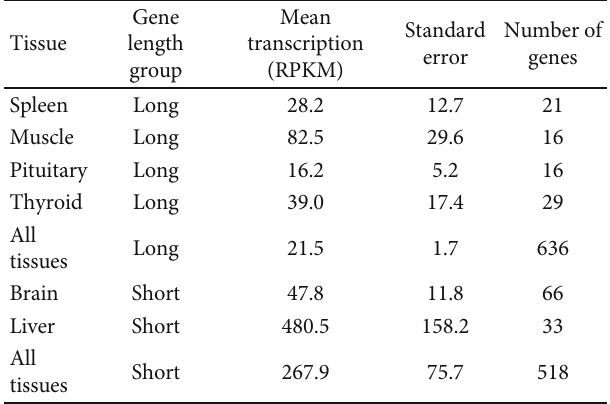
Figure 5: Distribution of database short, midlength, and long genes in ten human tissues. Values shown in plotted form here are selected from the longer list in Table 2. Note that tissues have distinct patterns of short, midlength, and long expressed genes. Table 3: E ff ect of tissue on expression of genes in the same length